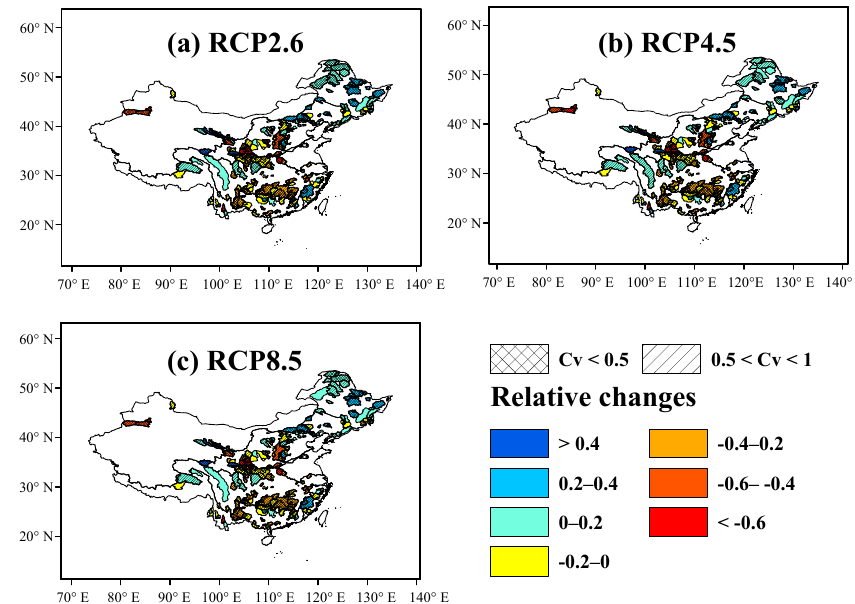
Figure 14. Spatial distribution of the model-averaged relative changes in mean annual runoff Q ( = (cid:49)Q e /Q ) for the period 2001–2050 under (a) RCP2.6, (b) RCP4.5, and (c) RCP8.5